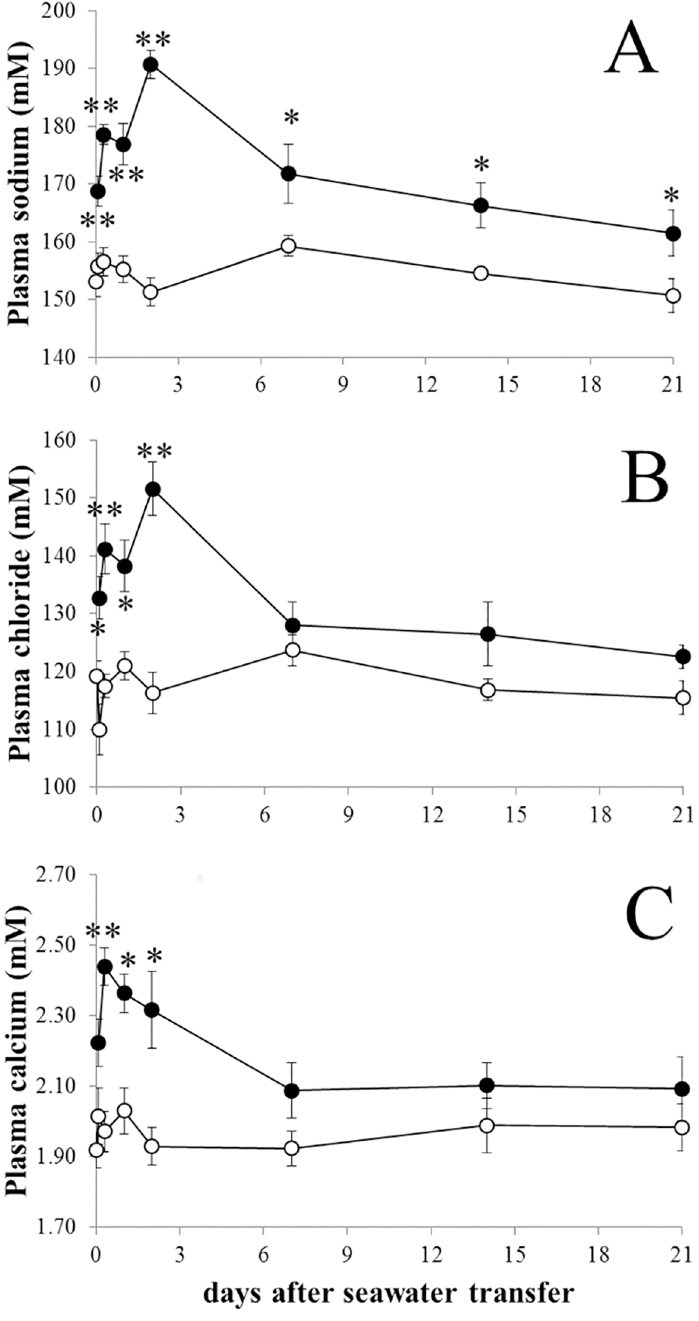
Fig 1. Plasma ion concentrations after sea water transfer. Mean plasma sodium (A), chloride (B), and calcium (C) from time 0 to 21 days post sea water transfer. Open and filled circles represent respectively freshwater and seawater transferred trout. Values represent means ± s.e.m. of six fishes. Differences between freshwater and seawater at each time point were assessed with non-parametric Mann-Whitney U- test after non-parametric analysis of variance (Kruskal-Wallis test). * and ** , significantly different from the corresponding values in freshwater at P < 0.05 and P <